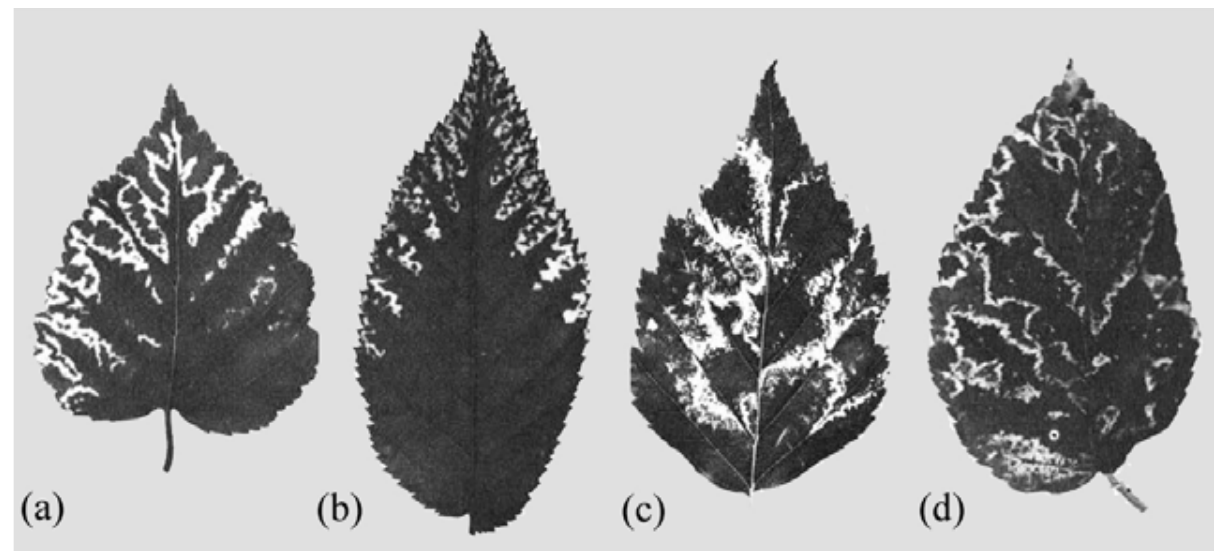
Figure 5. Symptoms associated with infection by ApMV in the form of line patterns and/or chlorotic rings on white birch leaves (a), (b), (c) and (d) (Reproduced with permission of the copyright owner from Gotlieb and Berbee,